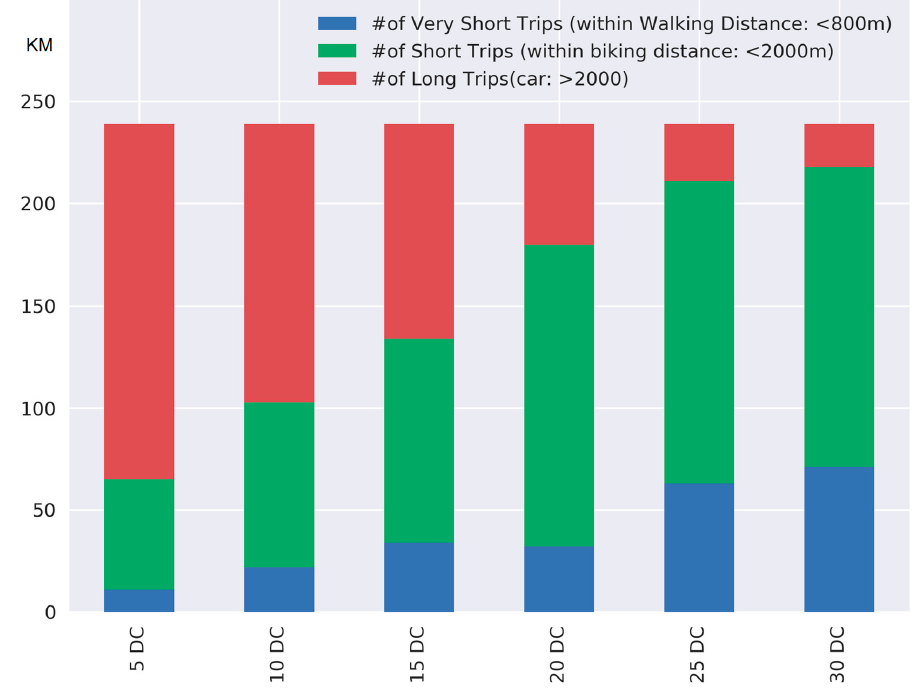
Figure 3. Analysis on an aggregate level.